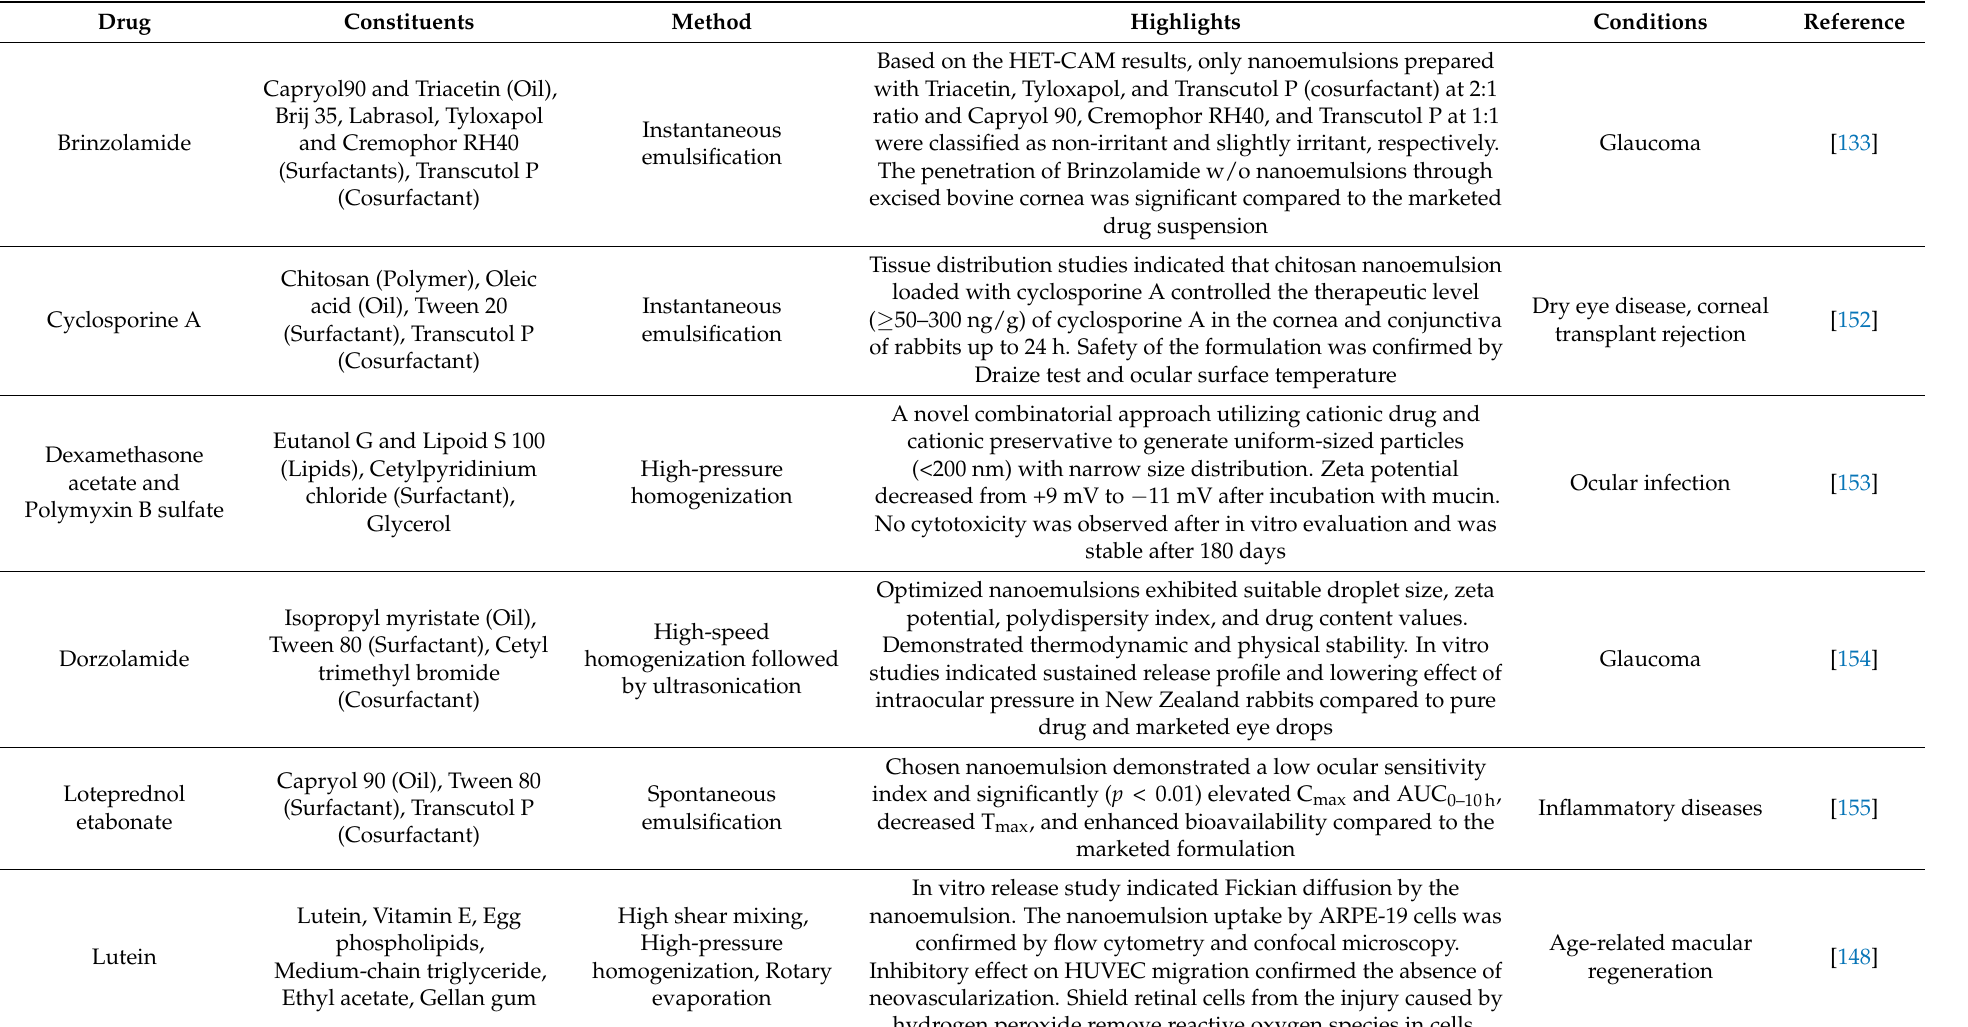
Table 6. An outline of different nanoemulsion-based formulations prepared for various ocular